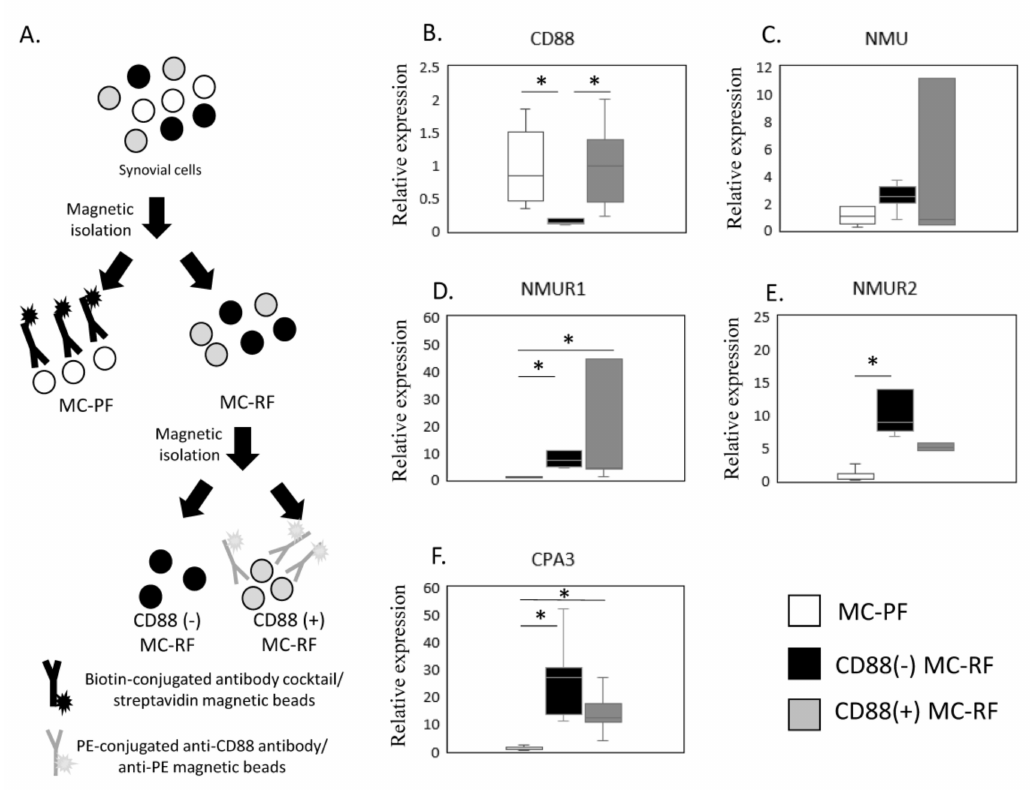
Figure 3. Expression of NMU / NMURs and CPA3 . ( A ) Schematic showing the process used to isolate the mast cell (MC)-poor fraction (MC-PF; THY-1+, CD3+, CD14+, or CD19+CD235+) and CD88( − ) and CD88(+) MC-rich fractions (MC-RFs; THY-1-CD3-CD14-CD19-CD235-). MC-RF and MC-PF were magnetically separated from other synovium-derived cells using biotin-conjugated antibody cocktails and streptavidin beads. Subsequently, the MC-RF was further divided into CD88( − ) and CD88(+) MC-RFs using PE-conjugated anti-CD88 antibody and anti-PE beads. The expression of NMU/NMURs and CPA3 mRNA in non-MC and CD88( − ) and CD88(+) MC fractions was estimated by qPCR ( B – F ). CD88 ( B ), NMU ( C ), NMUR1 ( D ), NMUR2 ( E ), and CPA3 ( F ) expression levels in MC-PF and CD88( − ) and CD88(+) MC-RF derived from the synovial membrane of obese KOA patients ( n = 5). * p <